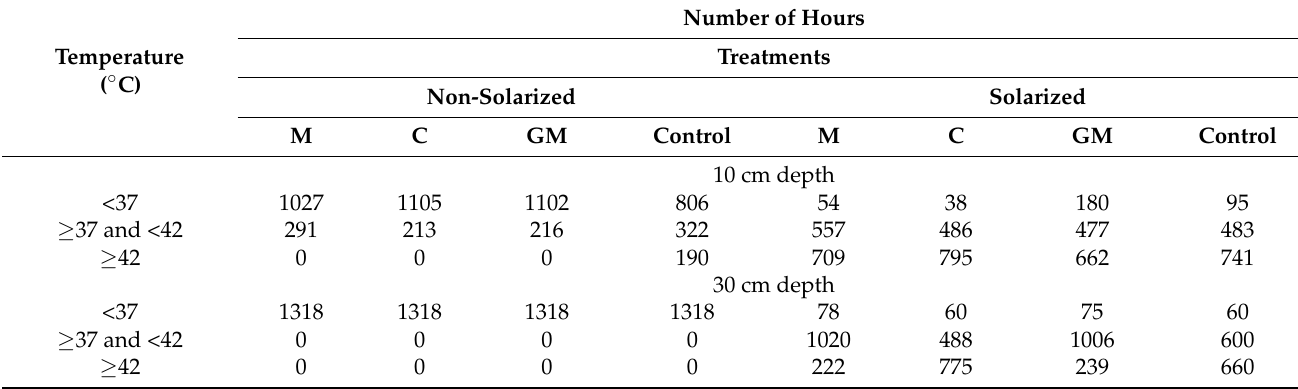
Table 1. Number of hours at different soil temperature range.